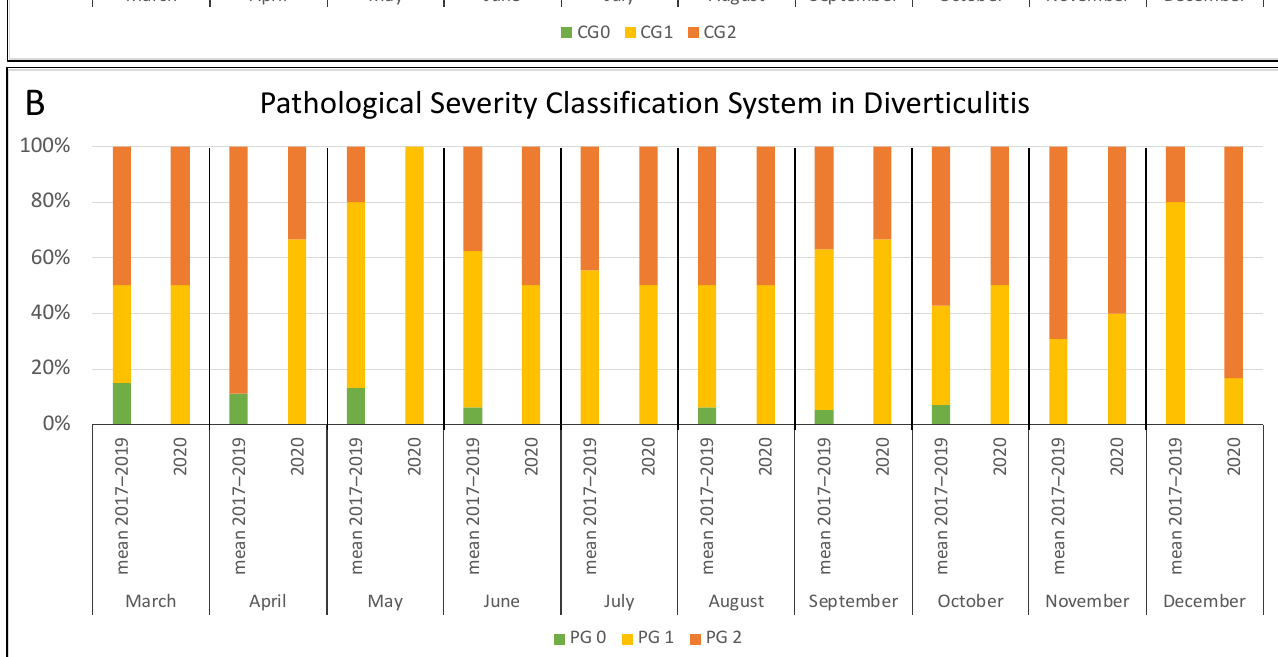
Figure 4. Monthly distribution of patients undergoing surgery for diverticulitis according to the clinical ( A ) and pathological ( B ) severity classification system: comparison between the 2017–2019 period and 2020.